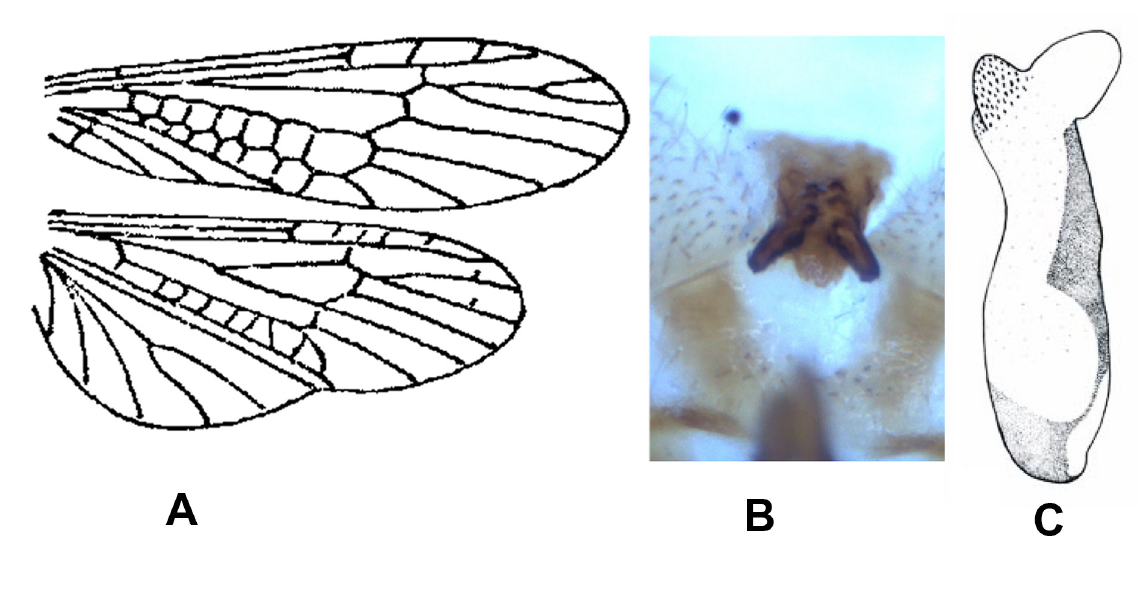
Fig. 15. A . Wings of Chinoperla nigroflavata (Wu, 1948), drawing modified from Wu (1948). B . Median sclerite of tergum 9 of C. biprojecta Lü, Yan, Li & Wang, 2019, dorsal view, illustration from Lü et al. (2019a). C . Aedeagus of C. mengmanensis Qian & Du, 2012, lateral view, drawing modified from Qian & Du (2012). Not to